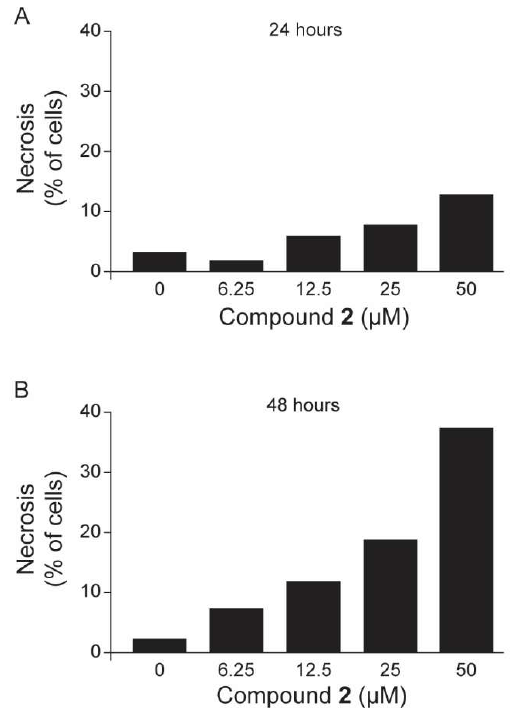
Figure 4. Treatment with compound 2 caused parasite death by inducing necrosis. Trypomastigotes were treated for 24 and 48 h with 2 at 6.25 µM, 12.5 µM, 25 µM, and 50 µM. Parasites were examined by flow cytometry with annexin V and PI staining. ( A ) Relationship between concentration of compound 2 and percentage of necrosis after 24 h treatment. ( B ) Relationship between concentration of compound 2 and percentage of necrosis after 48 h treatment.